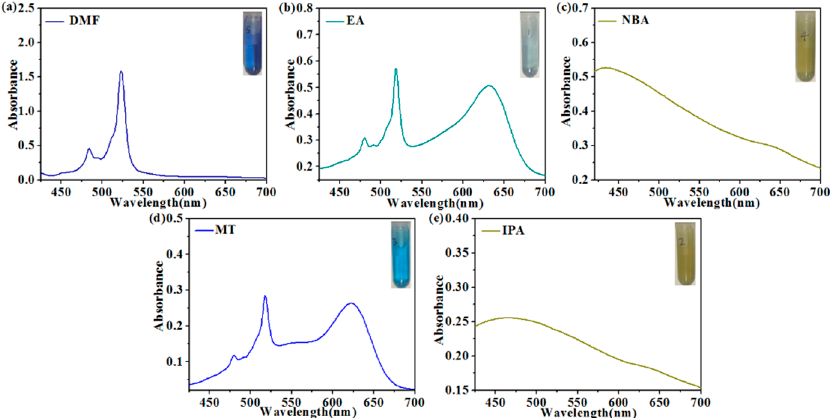
Figure 2. The UV-vis spectrum of the raw material dispersed in N , N -dimethylformamide ( a ), ethanol ( b ), n -butanol ( c ), methanol ( d ), and isopropanol ( e ); the insets are photographs of the solution under ambient